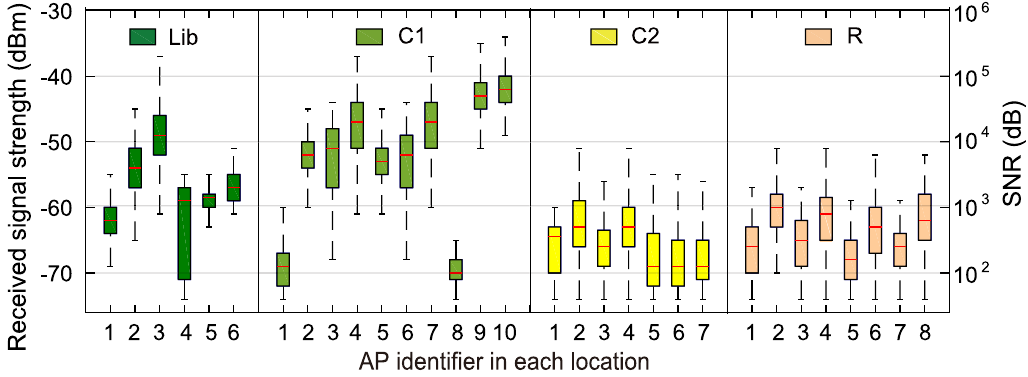
Fig 8. Received signal strength/SNR of usable APs in each